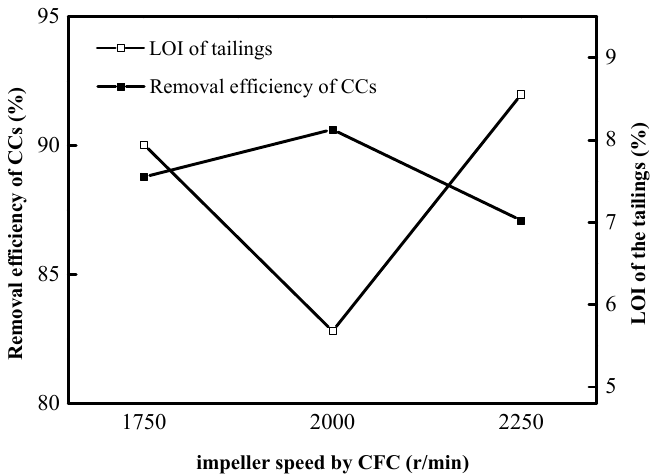
Figure 10. Effect of the impeller speed on decarburization by CFC: kerosene = 3 g/kg·ash, MIBC = 0.1 g/kg·ash, Tween 80 = 5% of the kerosene dosage, and slurry concentration = 100